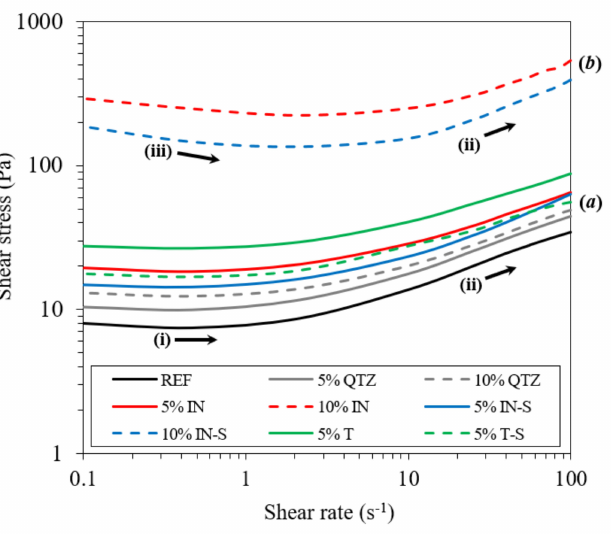
Figure 4. Flow curves of the pastes. Note: IN = in natura, S = saturated; T = treated; QTZ =